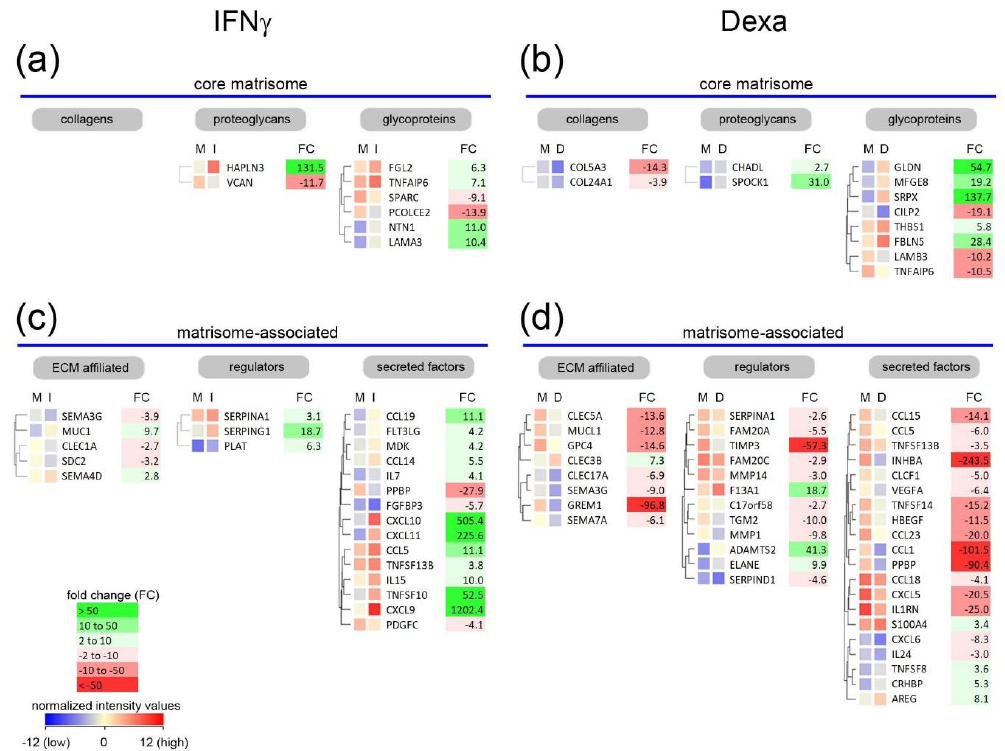
Figure 4. Cluster analysis of regulated matrisome genes in macrophages stimulated with IFN γ or